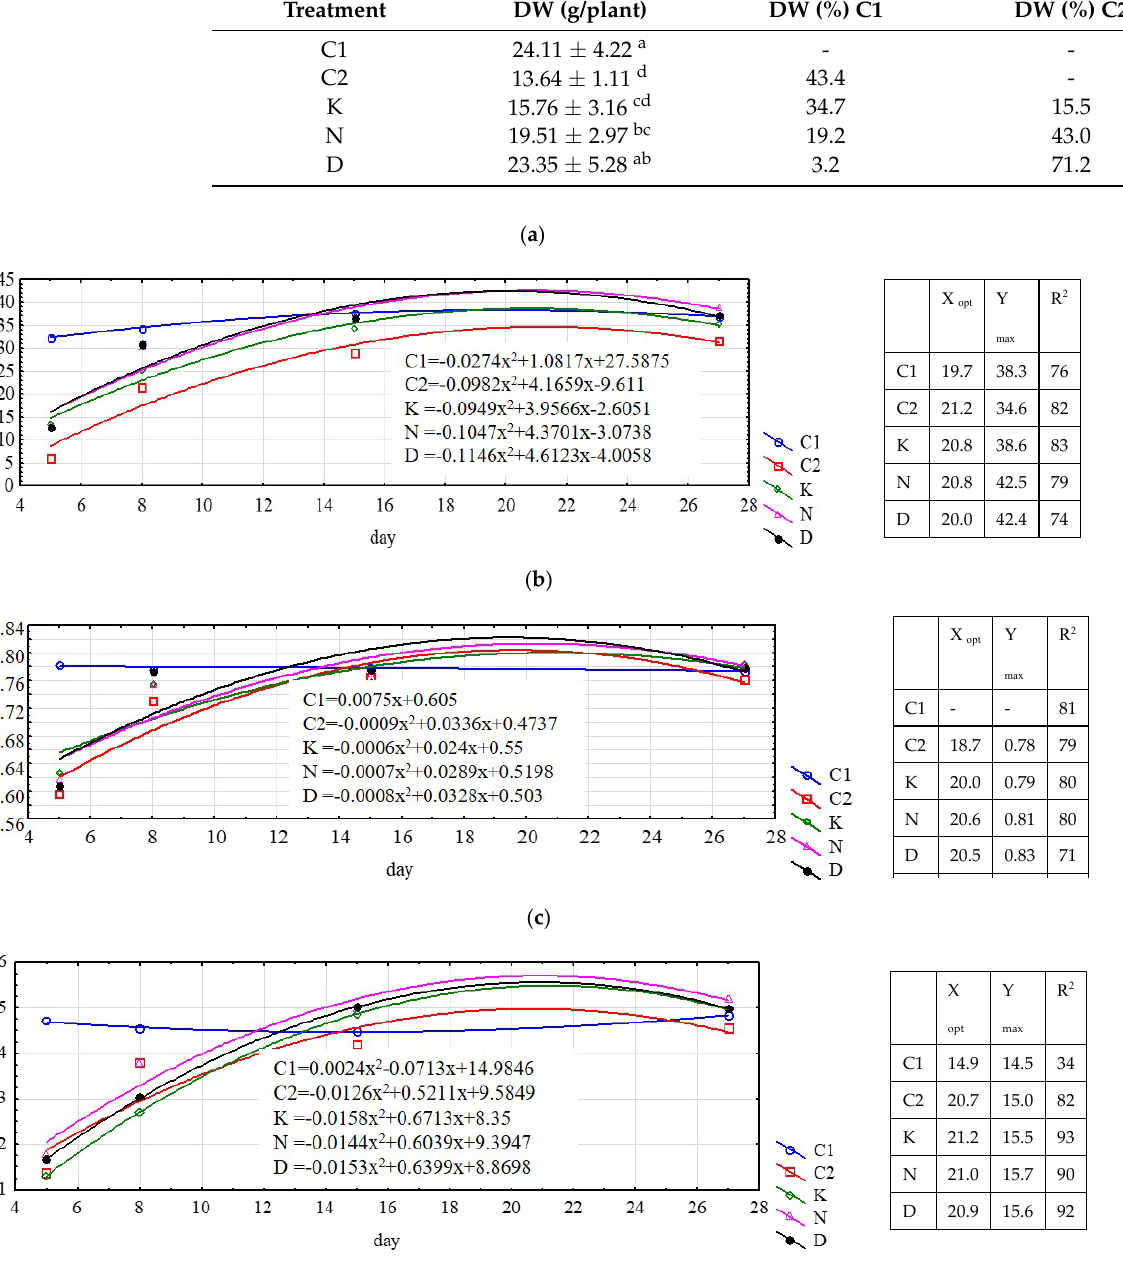
rate (P N max ) ( a ), maximum photosynthetic efficiency of PS II (Fv/Fm) ( b ) and electron transport rate (ETR) ( c ). Control treatment under normal growth conditions without cold stress (C1), second control treatment under stress growth conditions with cold (C2), Kelpak ® (K), Nano Active ® (N), Dynamic Cresco ® (D), X optimum (X opt ), Y maximum (Y max ) , determination coefficient (R 2 ) .